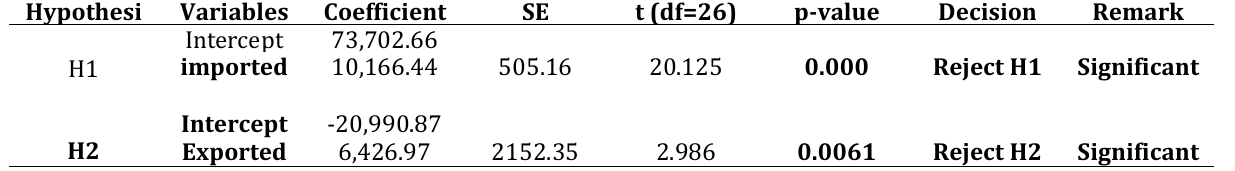
Table 9: Test of significance of hypothesis one and hypothesis two